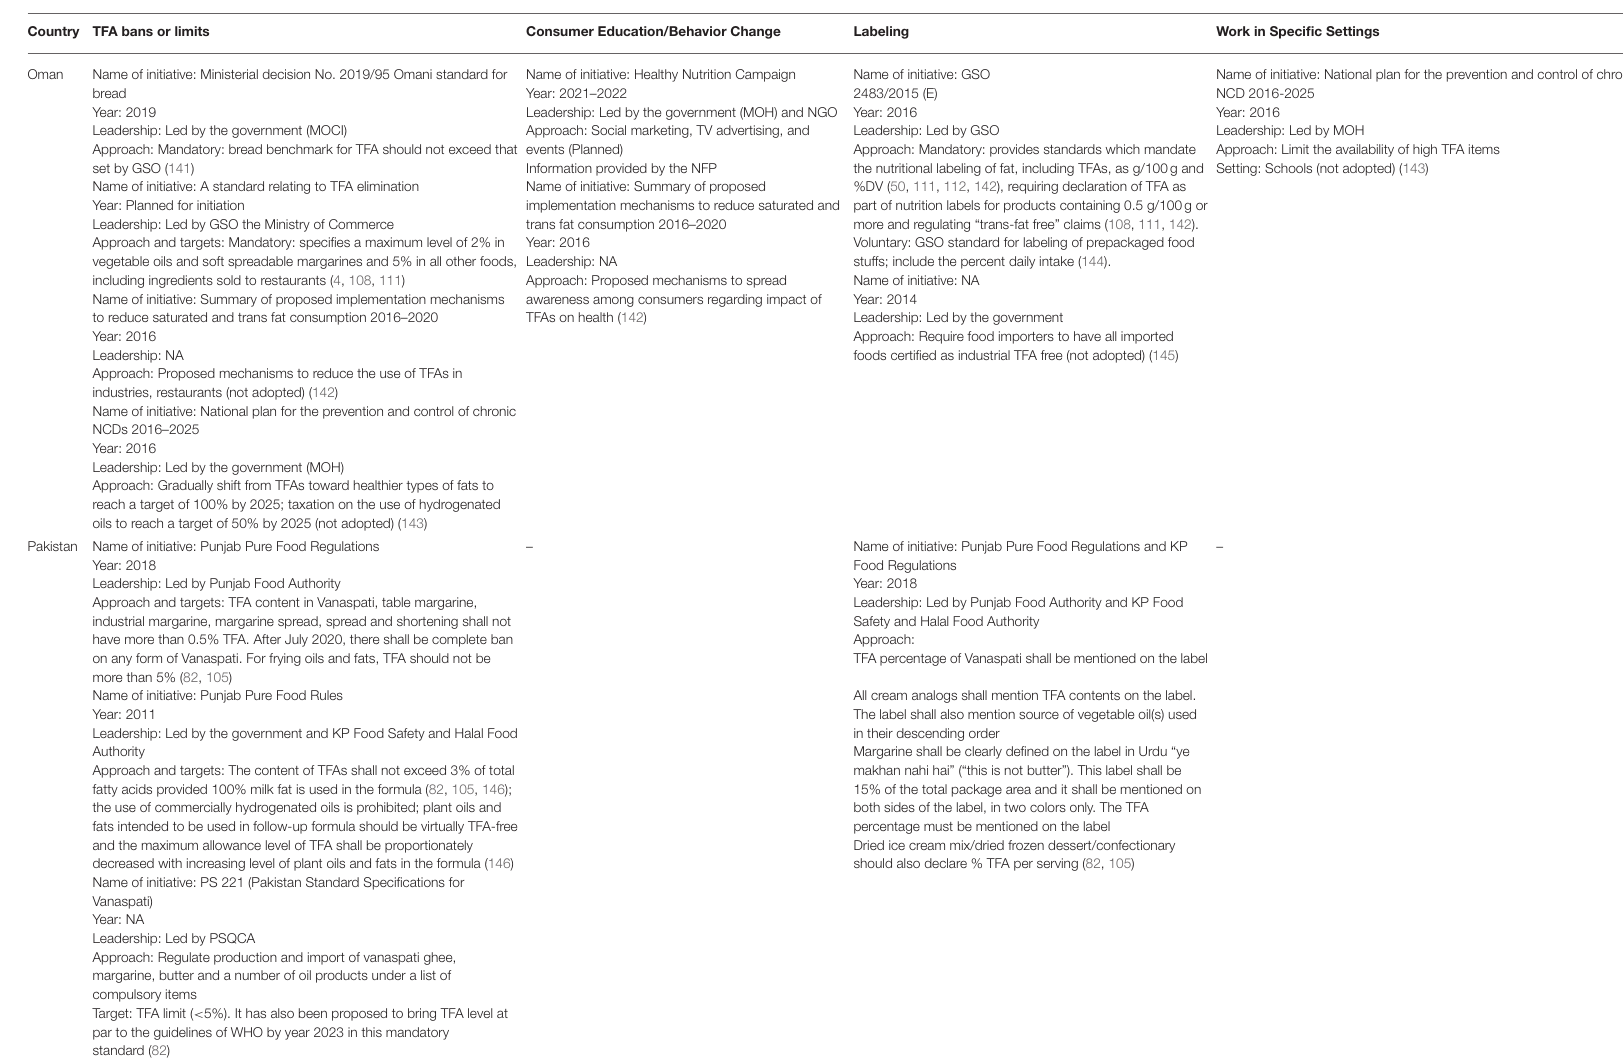
Country TFA bans or limits